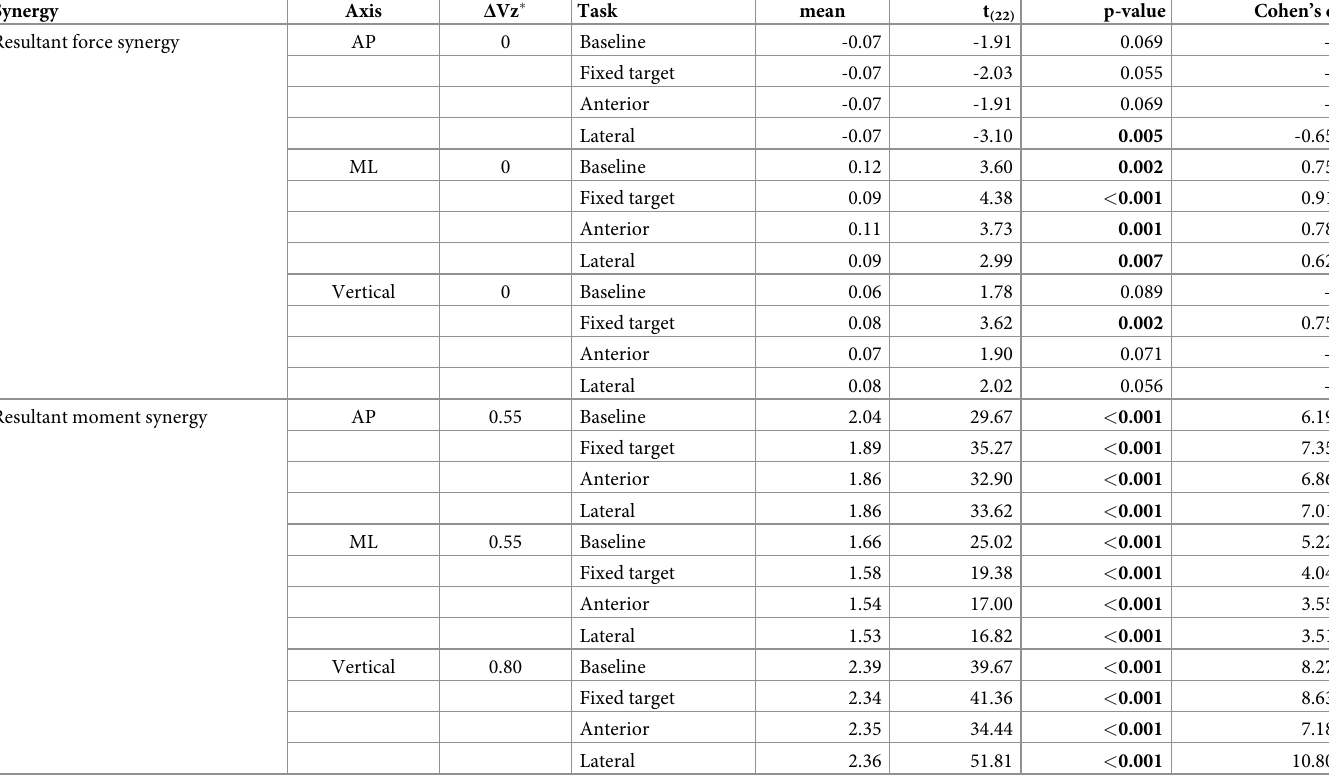
Table 2. One-sample t-tests to determine whether the synergy index ( Δ Vz) is different from the corresponding discriminating value ( Δ Vz � ) for the three resultant force and the three resultant moment components for each task. Synergy